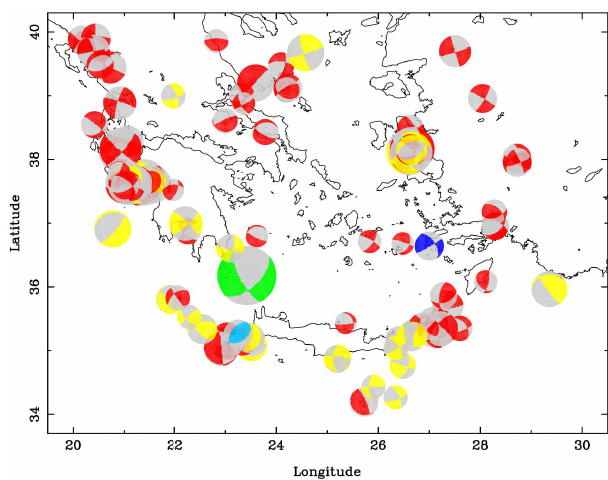
Fig. 1. Map of earthquakes for which focal mechanisms could be determined by waveform inversion. Colour of beach balls indicates source depth. Red: 0–20km, yellow: 20–40km, green: 40–80km, blue: 80–100km, deep blue: 100–150km, magenta: > 150km. Size of beach ball indicates